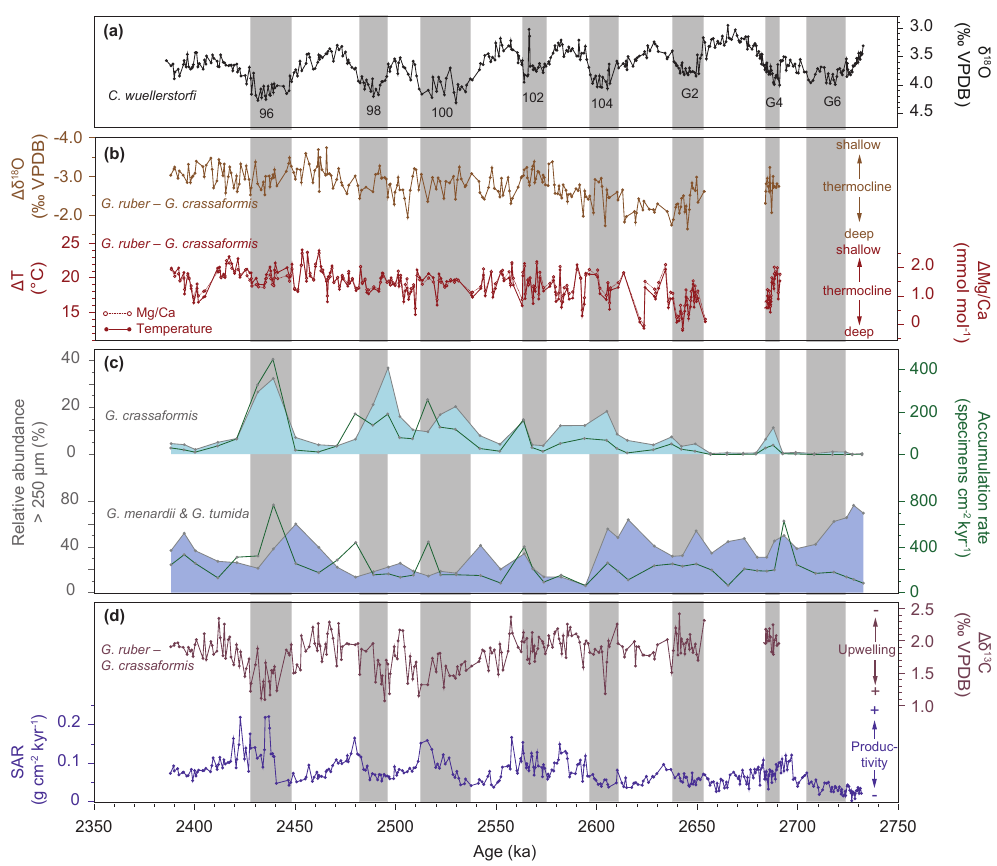
Figure 7. Compilation of planktic foraminiferal, faunal and sedimentary proxy records from ODP Site 849 for MIS G7–95 ( ∼ 2 . 75–2.4Ma). (a) Benthic foraminiferal ( C. wuellerstorfi ) δ 18 O stratigraphy (Jakob et al., 2017). (b) δ 18 O (brown; this study) and Mg / Ca (red dashed line with open dots; this study) and temperature (red; this study) gradients between the surface-dwelling species G. ruber and the thermocline- dwelling species G. crassaformis as a proxy for relative thermocline depth. (c) Relative abundances of G. crassaformis (light blue; this study) and G. menardii and G. tumida (dark blue; this study) in addition to their mass accumulation rates (green; this study). (d) δ 13 C gradient between G. ruber and G. crassaformis as an indicator for upwelling strength (purple; Jakob et al., 2016, this study) in addition to sand accumulation rates (SAR) as an indicator for primary productivity (Jakob et al., 2016, this study). Gaps in the δ 18 O, δ 13 C and Mg / Ca gradients for 2.68–2.65Ma (MIS G3) and 2.73–2.69Ma (MIS G7–G5) are due to a lack of G. crassaformis specimens in the investigated size fraction (315–400µm). Grey bars highlight glacial